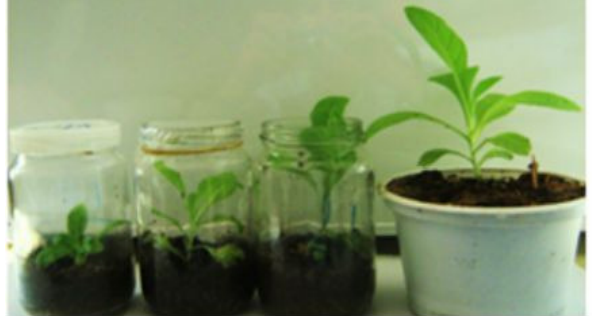
Fig. 1. Adaptation stages of haploid plants